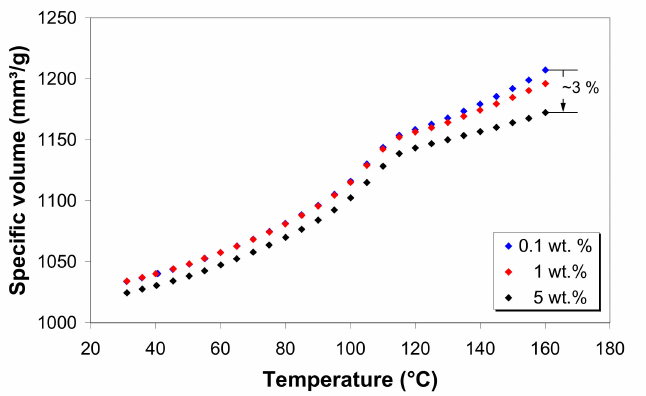
Figure 12. E ff ect of melt temperature and nanotube loading on the specific volume of the LDPE / MWCNT composites at 500